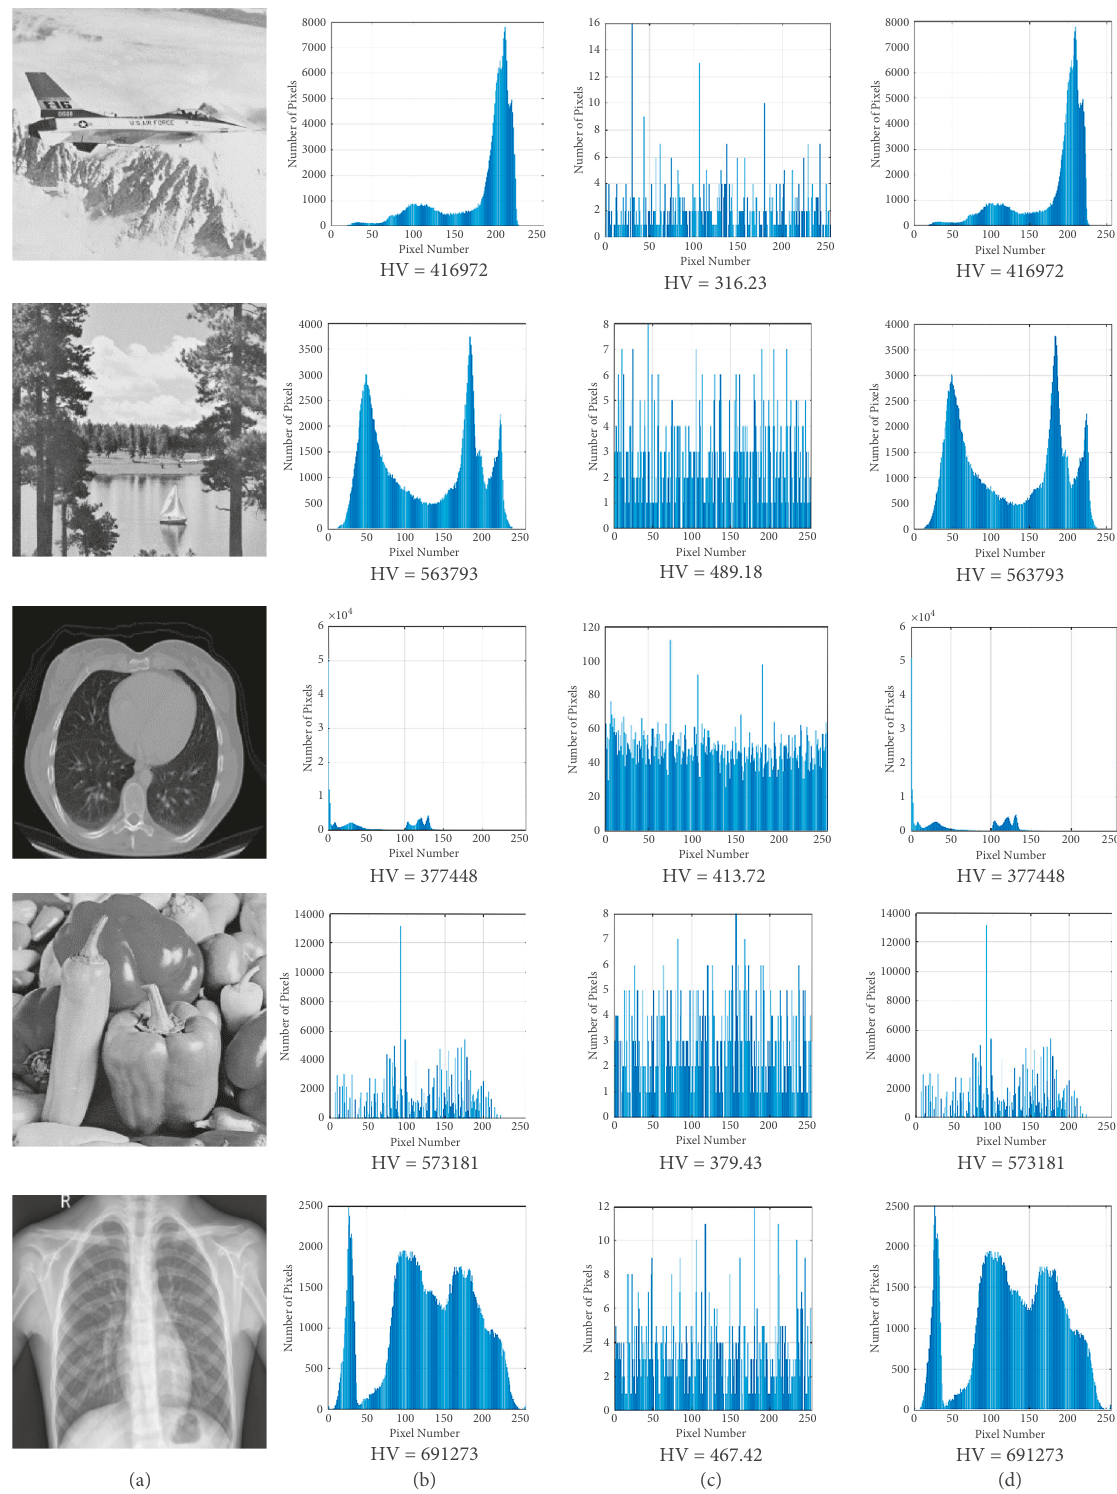
Figure 10: (a) Input image, (b) input histogram, (c) encrypted image histogram, and (d) output image and